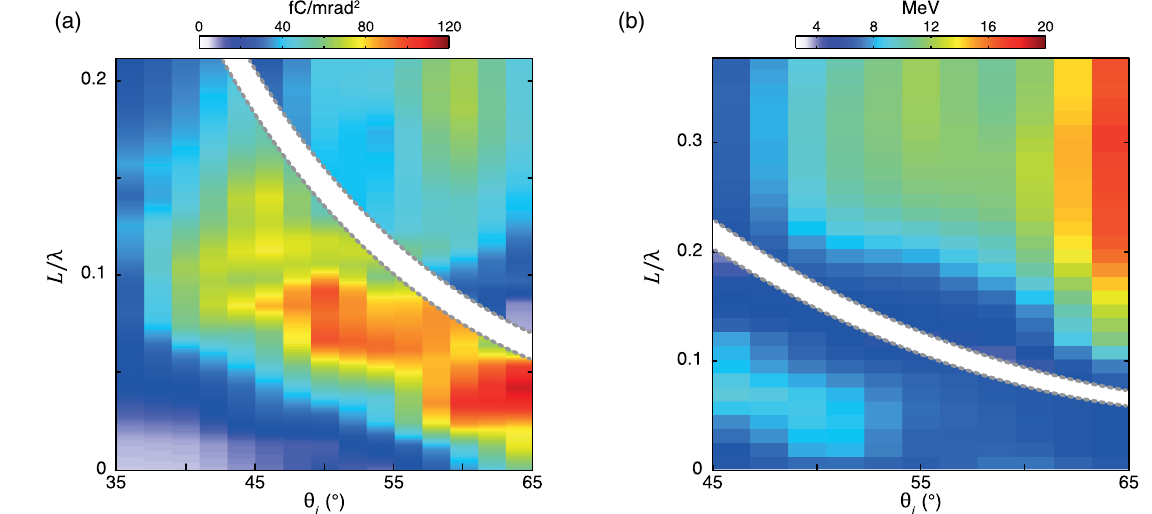
FIG. 13. Measured electron beam properties as a function of key interaction parameters. Panel (a) shows the experimental evolution of the number of emitted high-energy electrons ( E > 1 MeV) as a function of the incidence angle θ i and density gradient scale length L , for a ¼ 3 . 5 and p polarization of the laser. The white area corresponds to the transition between the Brunel and stochastic heating coupling 0 regimes, identified in Fig. 12. Below this border, the displayed signal corresponds to the integration of the electron beam spatial profile on the right of the ponderomotive hole (i.e., VLA electrons only). Above this border, it corresponds to the integration of the electron beam spatial profile on the left of this hole only. Panel (b) shows the average electron energy [ E m ¼ function of the same physical parameters. Here again, the electron spectra used for this calculation were selected on the right of the ponderomotive hole for short gradients, and on its left for long